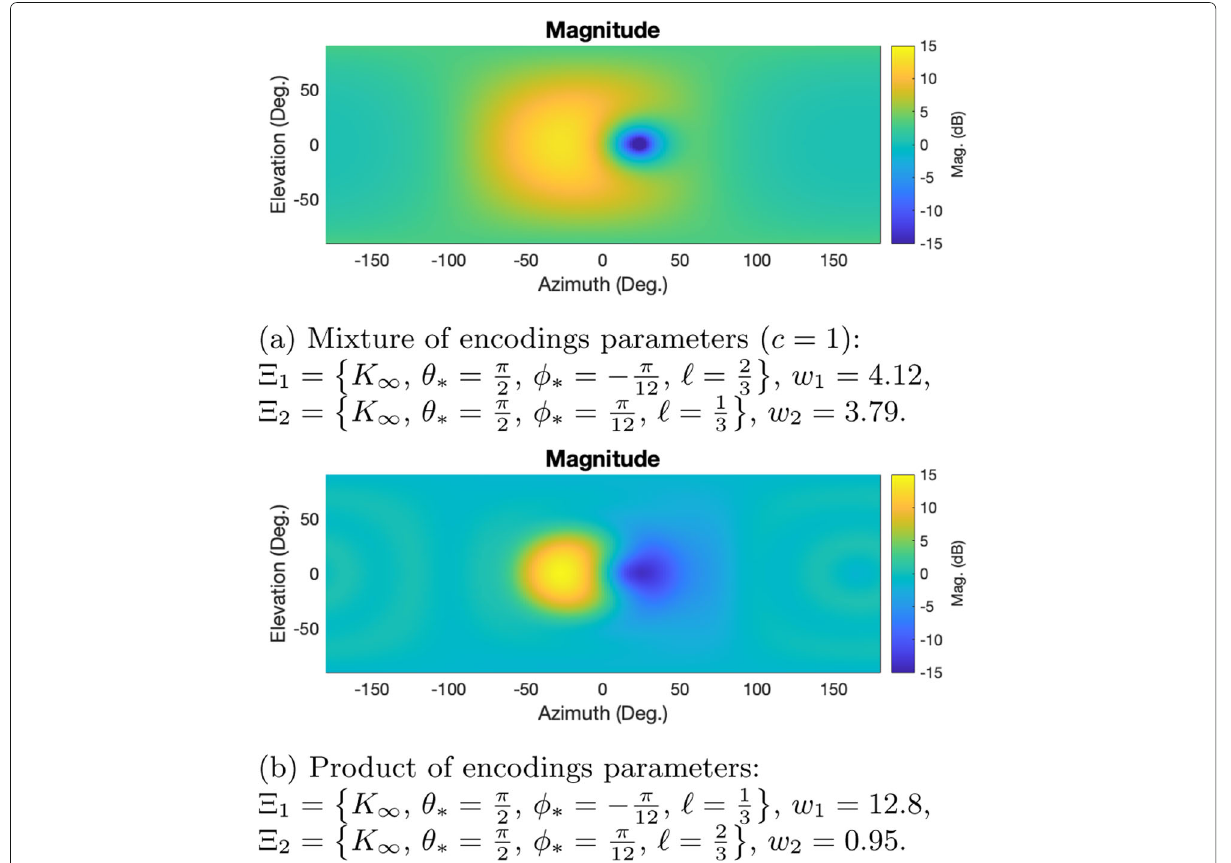
Fig. 3 Mixture and product of two K ∞ kernels from Eqs. 23, 28. Weights w are fitted to X = { 12 dB , − 12 dB } responses respectively at their centers of expansion (θ ∗ , φ ∗ ) . Only the magnitude responses are shown as the phase component is constant (0